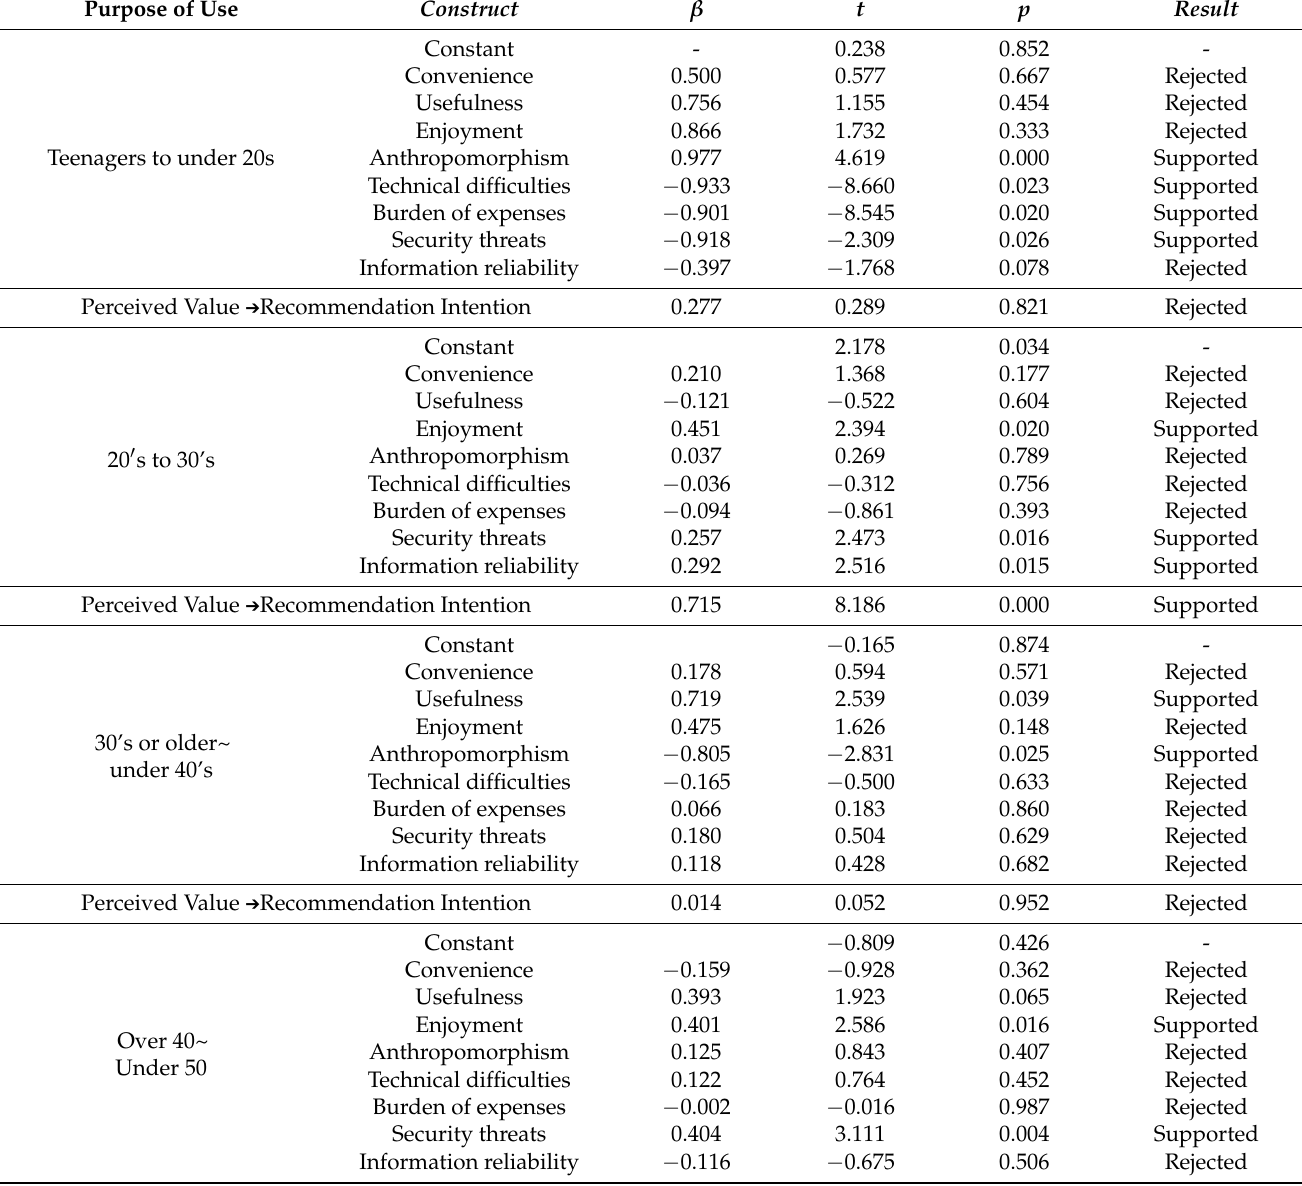
Table 9. Causal relationship analysis by